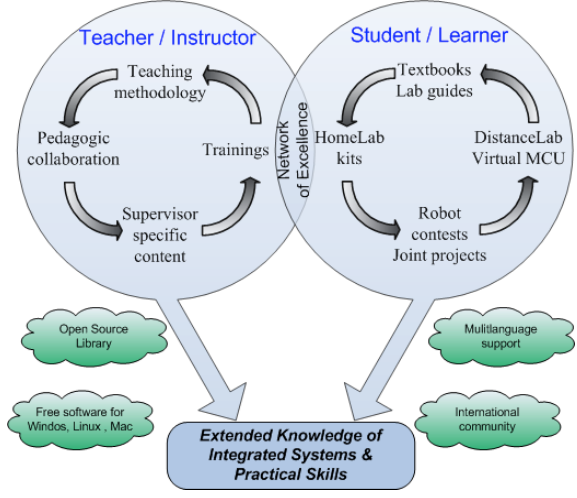
Figure 2. Robotic Teaching and Learning concept of tools and methodology to effectively and interactively teach embedded systems and mechatronics as well